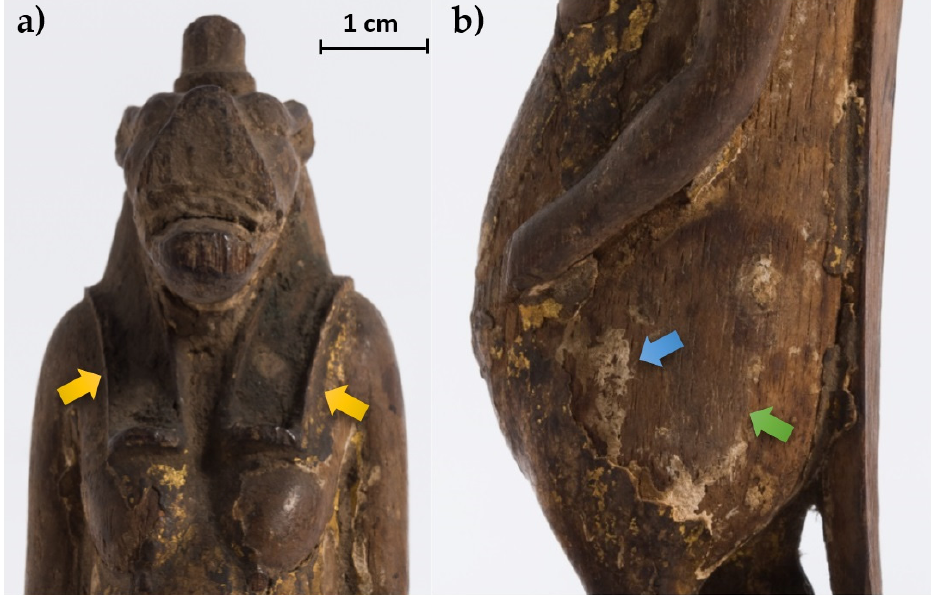
Figure 2. Some details of the statuette: ( a ) face and notches for the wig (yellow arrows); ( b ) detail of the body where the wood material (green arrow) and the preparation layer (blue arrow) are visible.